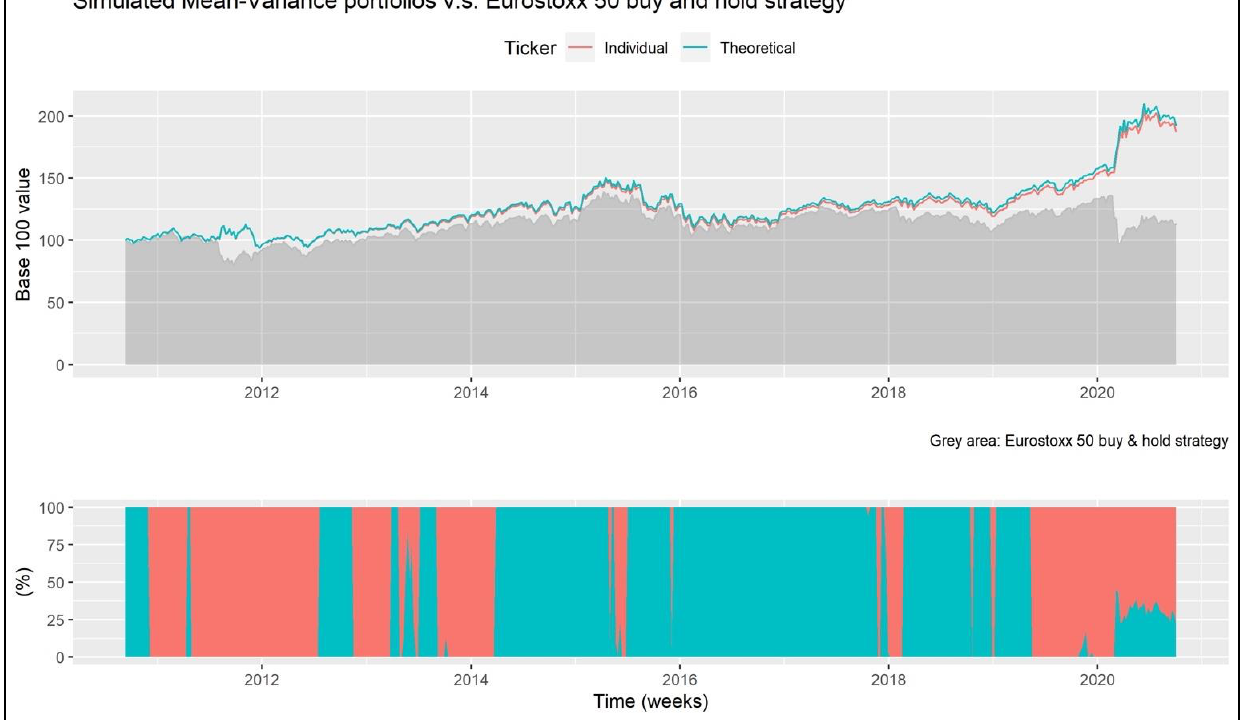
Figure 8. Weekly historical values of an individual investor that optimally selects two ETFs. One invested in the ESTOXX50 and another in portfolio 1 of the institutional simulated investor (Figure 7). Comparison against an ESTOXX50 buy-and-hold strategy.